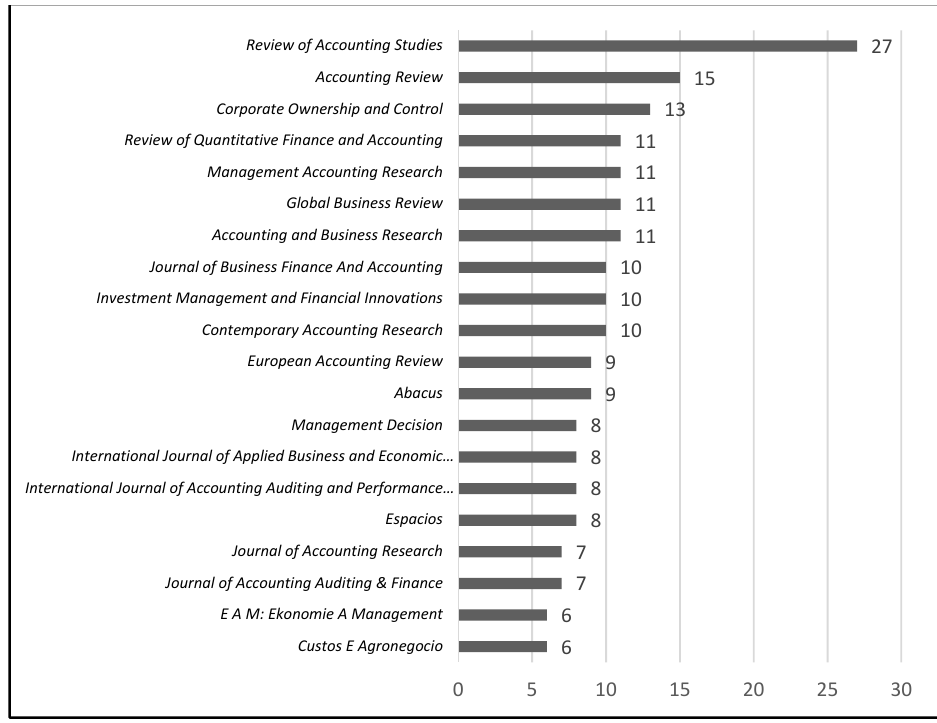
Figure 3. Leading Publishing Outlets in the Domain of EVA Research (Minimum Number of 6 Articles).